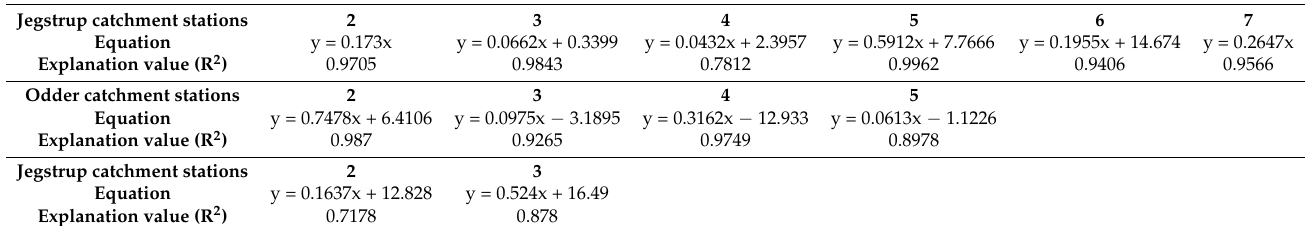
Table A1. Q-Q relationship for all the synchronous stations in the Jegstrup, Odder, and Saltø catchments. This relationship was used to calculate the daily mean discharge at the synchronous stations in the two monitoring